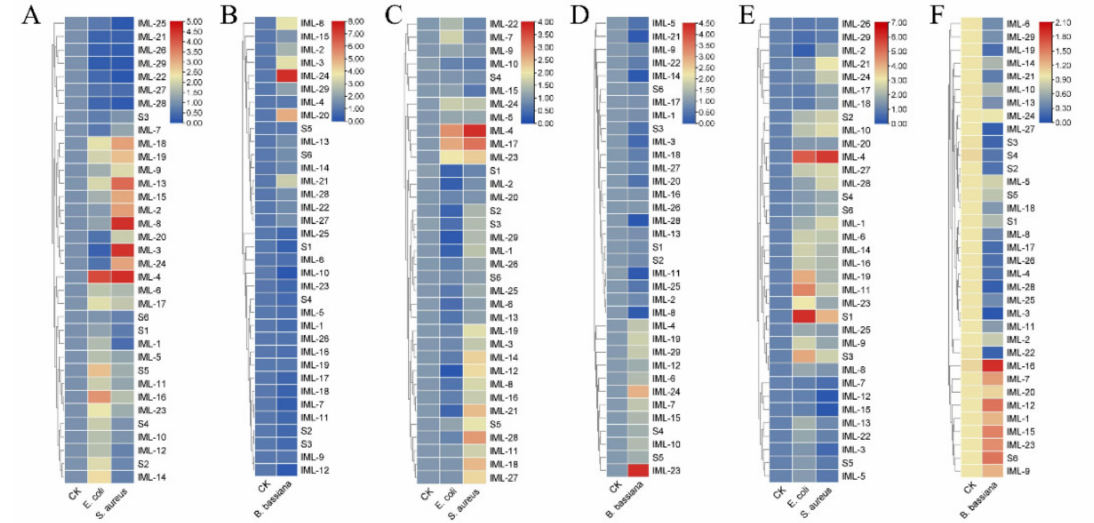
Figure 9. Expression of CTLs responding to E. coli , S. aureus , and B. bassiana conidia after 24 h. Formaldehyde-killed E. coli , S. aureus , and B. bassiana conidia were injected into fifth instar larvae. The expression of CTLs in hemocytes ( A , B ), fat body ( C , D ), and midgut ( E , F ) were analyzed by RT-qPCR. Values (log2) representing the relative expression levels were directly mapped to the color scale without normalization. Dendrograms were generated by the hierarchical clustering analysis of